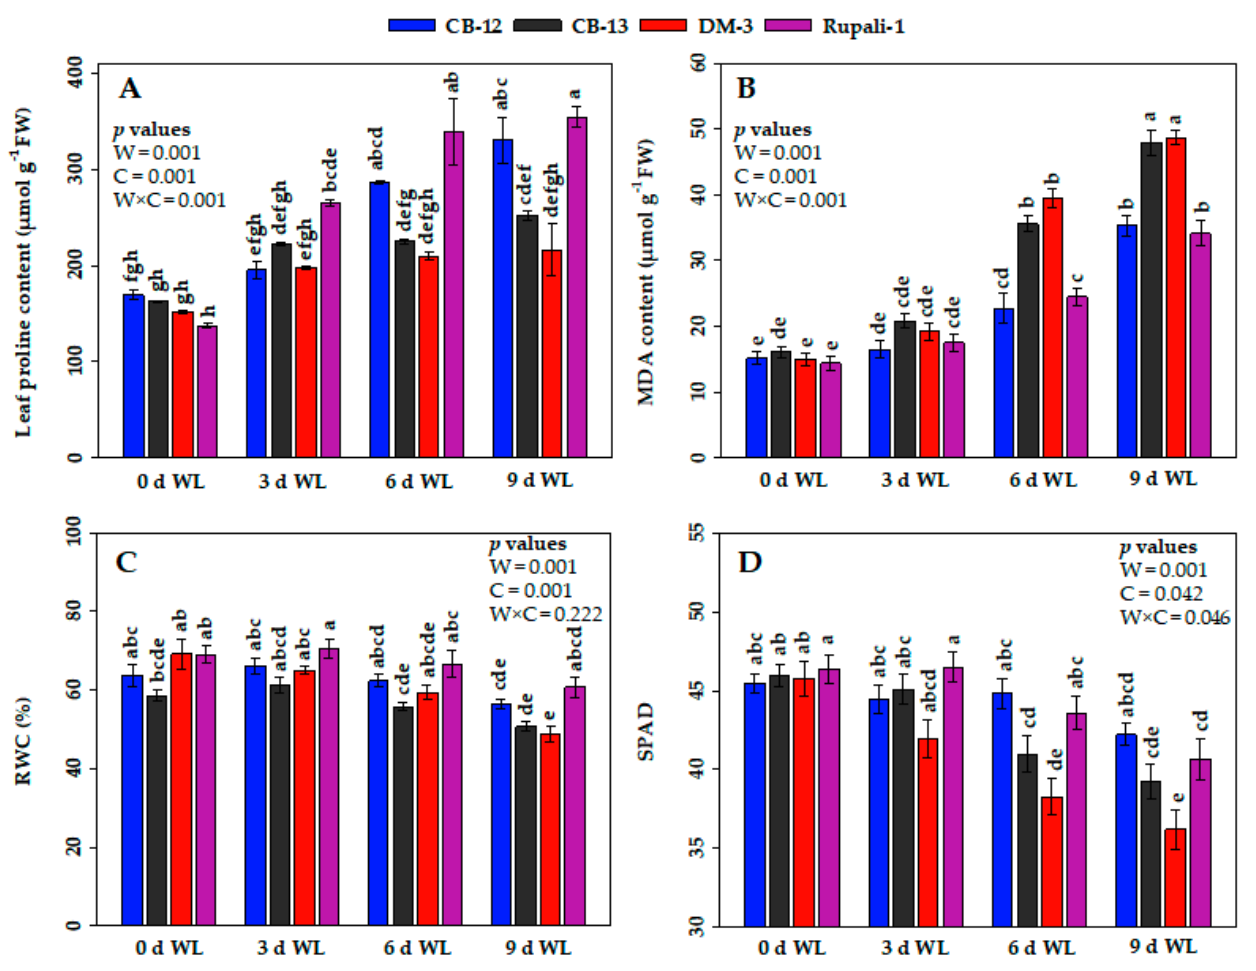
Figure 3. Effect of waterlogging (WL) on ( A ) leaf proline content, ( B ) malondialdehyde (MDA) content, ( C ) relative water content (RWC), and ( D ) SPAD values. Values are means ± standard error. Bars connected with different letters have significant differences. p values are presented at the top right corner of the graphs. W = WL duration, C = cotton cultivar, and W × C = interaction of WL duration and cotton cultivar. d, day(s); FW, fresh weight.